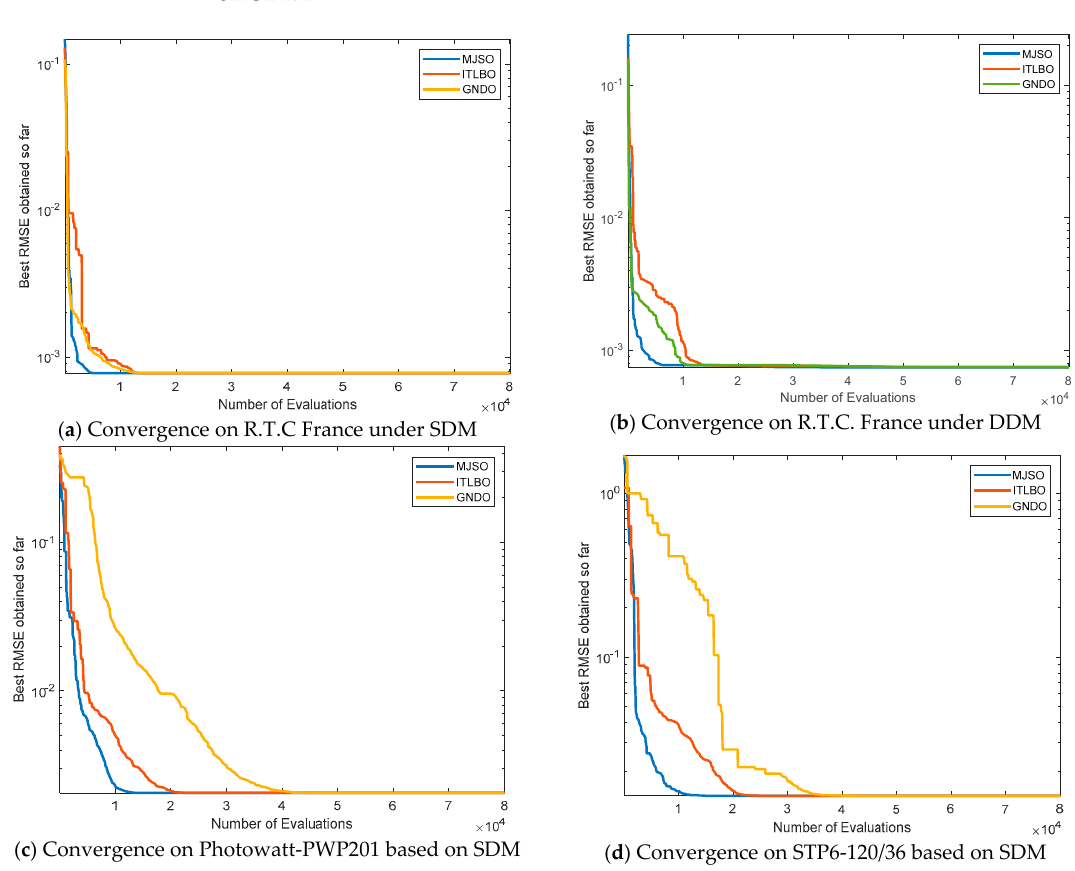
Figure 11. Comparison among the algorithms under the convergence speed.